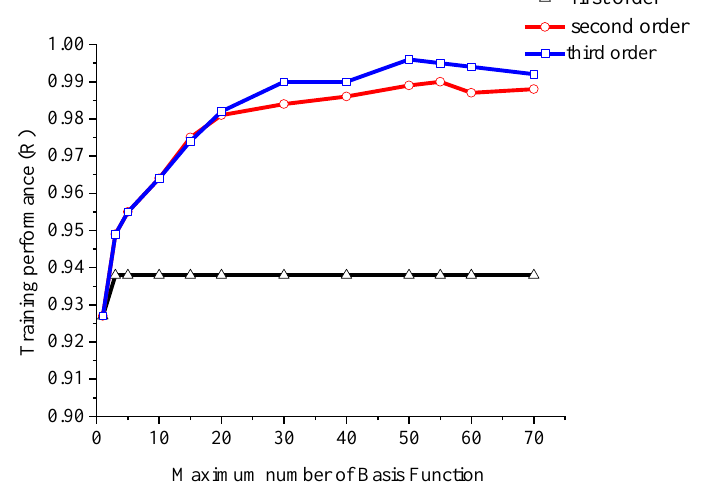
Figure 2. Effect of maximum number of basis functions as well as order on model performance R based on the training set of y.